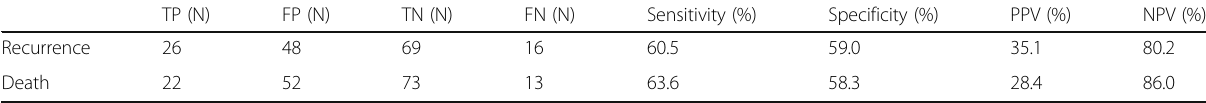
Table 2 Specificity and Sensitivity for predicting recurrence and death considering the H3K27me3 85% cut-off TP (N) FP (N) TN (N) FN (N) Sensitivity (%) Specificity (%) PPV (%) NPV (%) Recurrence 26 48 69 16 60.5 Death 22 52 73